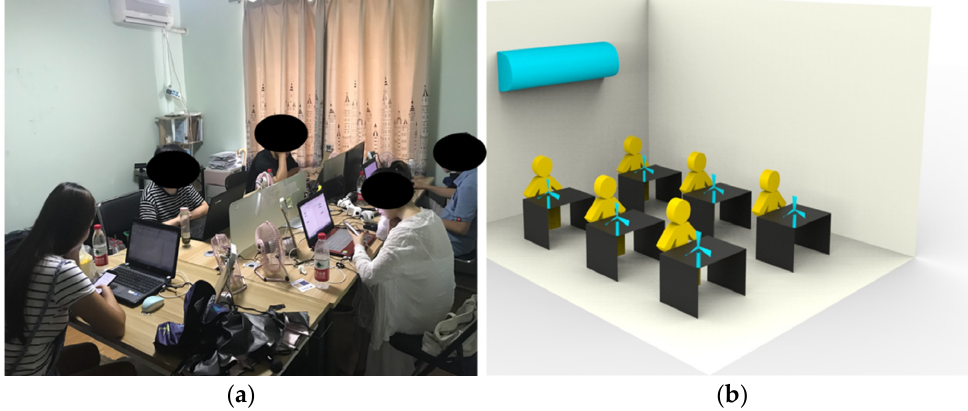
Figure 9. Test bed set-up. ( a ) A real test bed setup. ( b ) A 3D view of the proposed system.